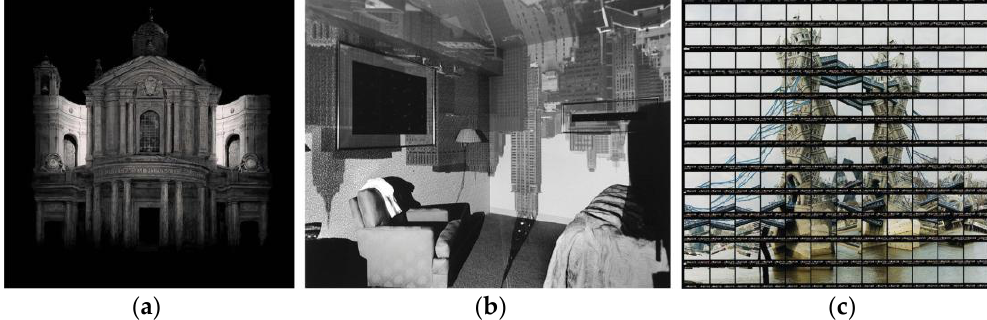
Figure 4. ( a ) Irene Kung, Santa Maria della Pace , Roma, 2007; ( b ) Abelardo Morell, Camera Obscura (New York), 1999; ( c ) Thomas Kellner, Tower Bridge , London,